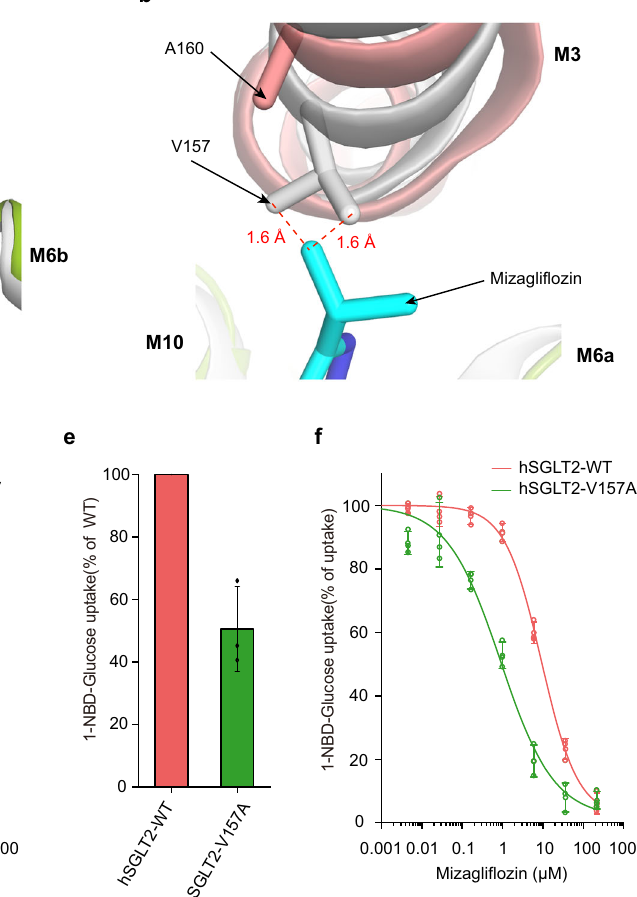
Fig.3|MechanismofSGLT1-speci fi cinhibitors.a Thestructuralsuperpositionof representative molecular dynamic simulation frame of hSGLT1 outward-open in com- plex with mizagli fl ozin (colored) onto the structure of hSGLT2 outward-open (gray, PDBID:7VSI).Mizagli fl ozinisshownassticks.The representative simulationframe used for structuralalignment isindicated in green circles showninSupplementary Fig.5a,b. b Theclose-upviewofthestericalclashesbetweenMizagli fl ozinandV157 of SGLT2. Inter-atom distances that are smaller than their van der Waals radii are